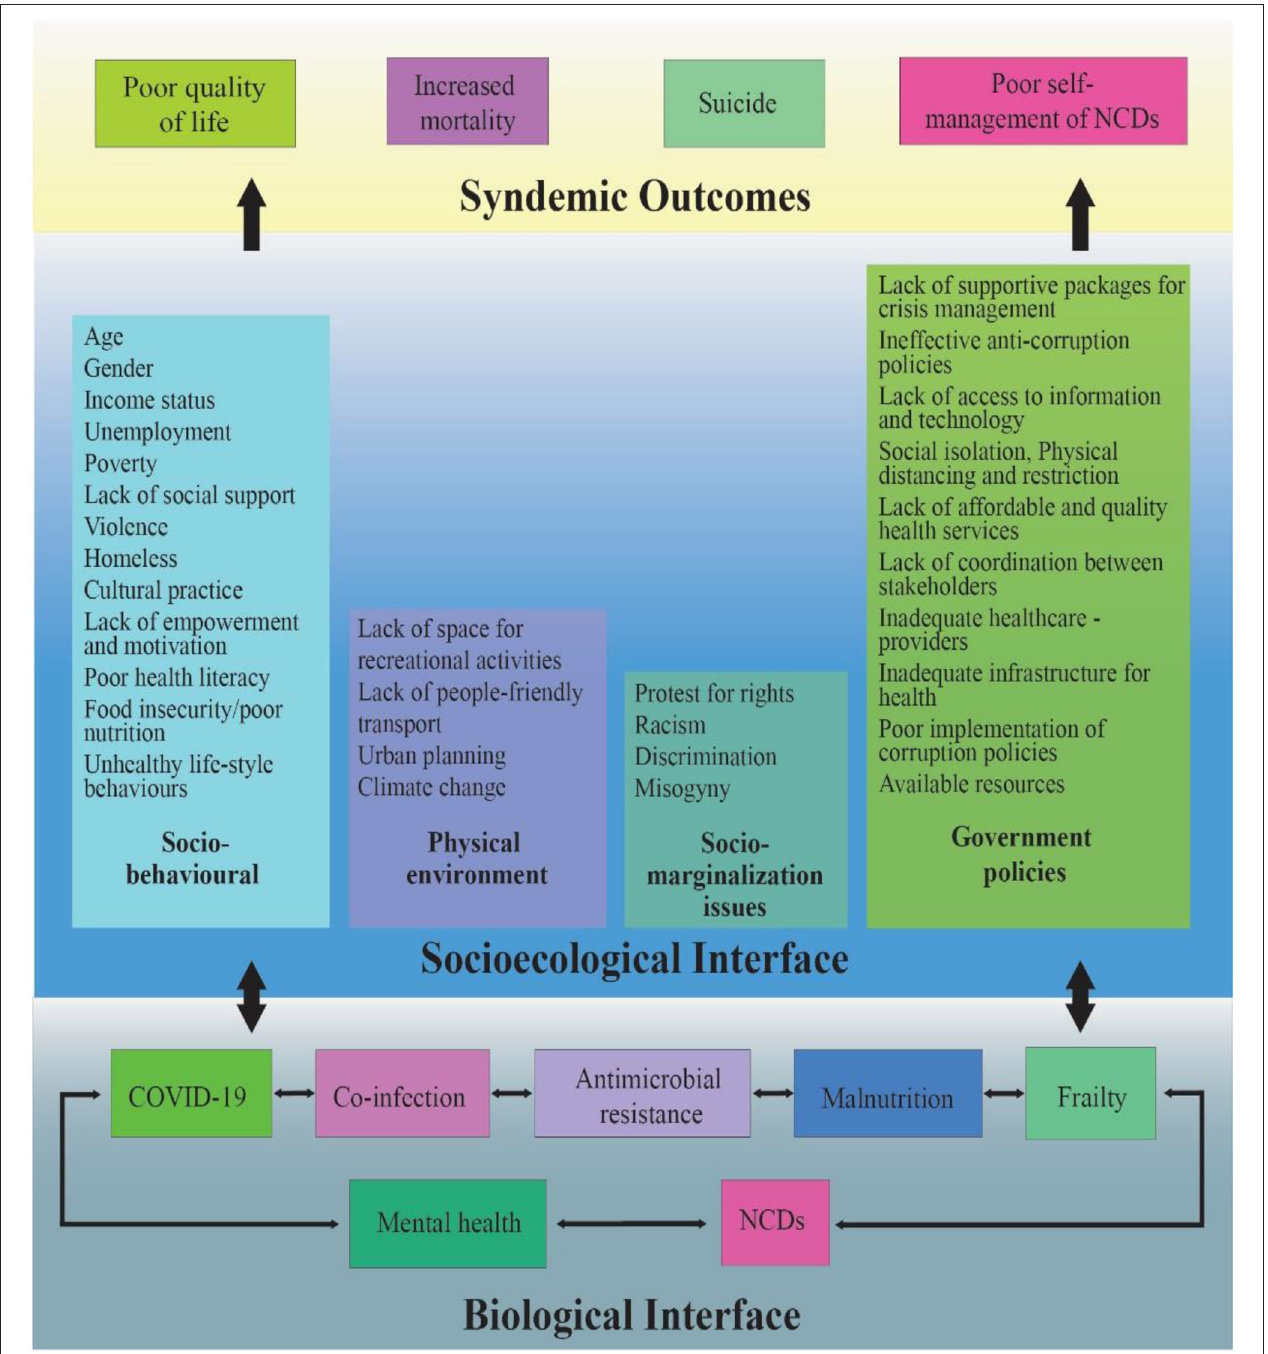
FIGURE 1 | Fueling factors responsible for COVID 19 syndemic outcomes among PLWNCDs [adapted from Singer (8), Bambra (9), and Shaiu (10)].